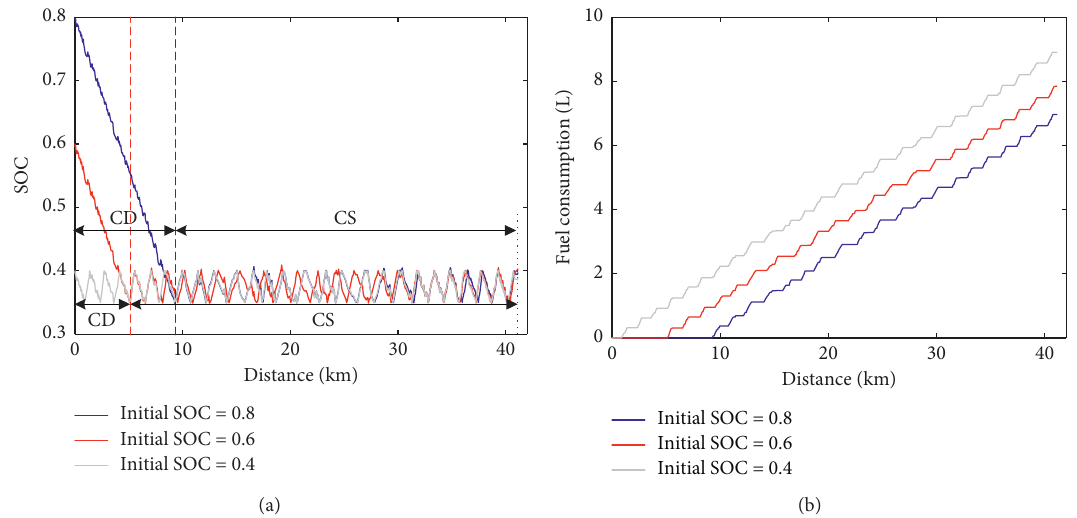
Figure 24: FC simulation of the synthesized driving cycle with different initial SOC. (a) SOC changing and (b) fuel